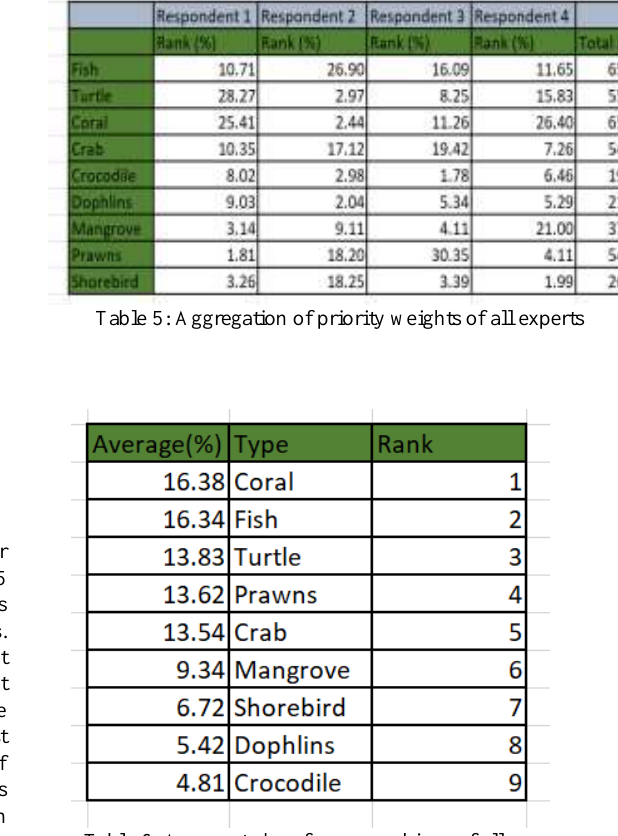
Table 6: Aggregated preference rankings of all